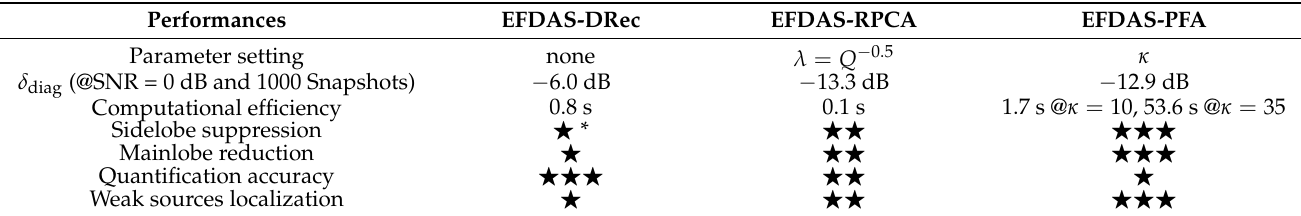
Table 2. The comparison among the performances of three EFDAS methods.